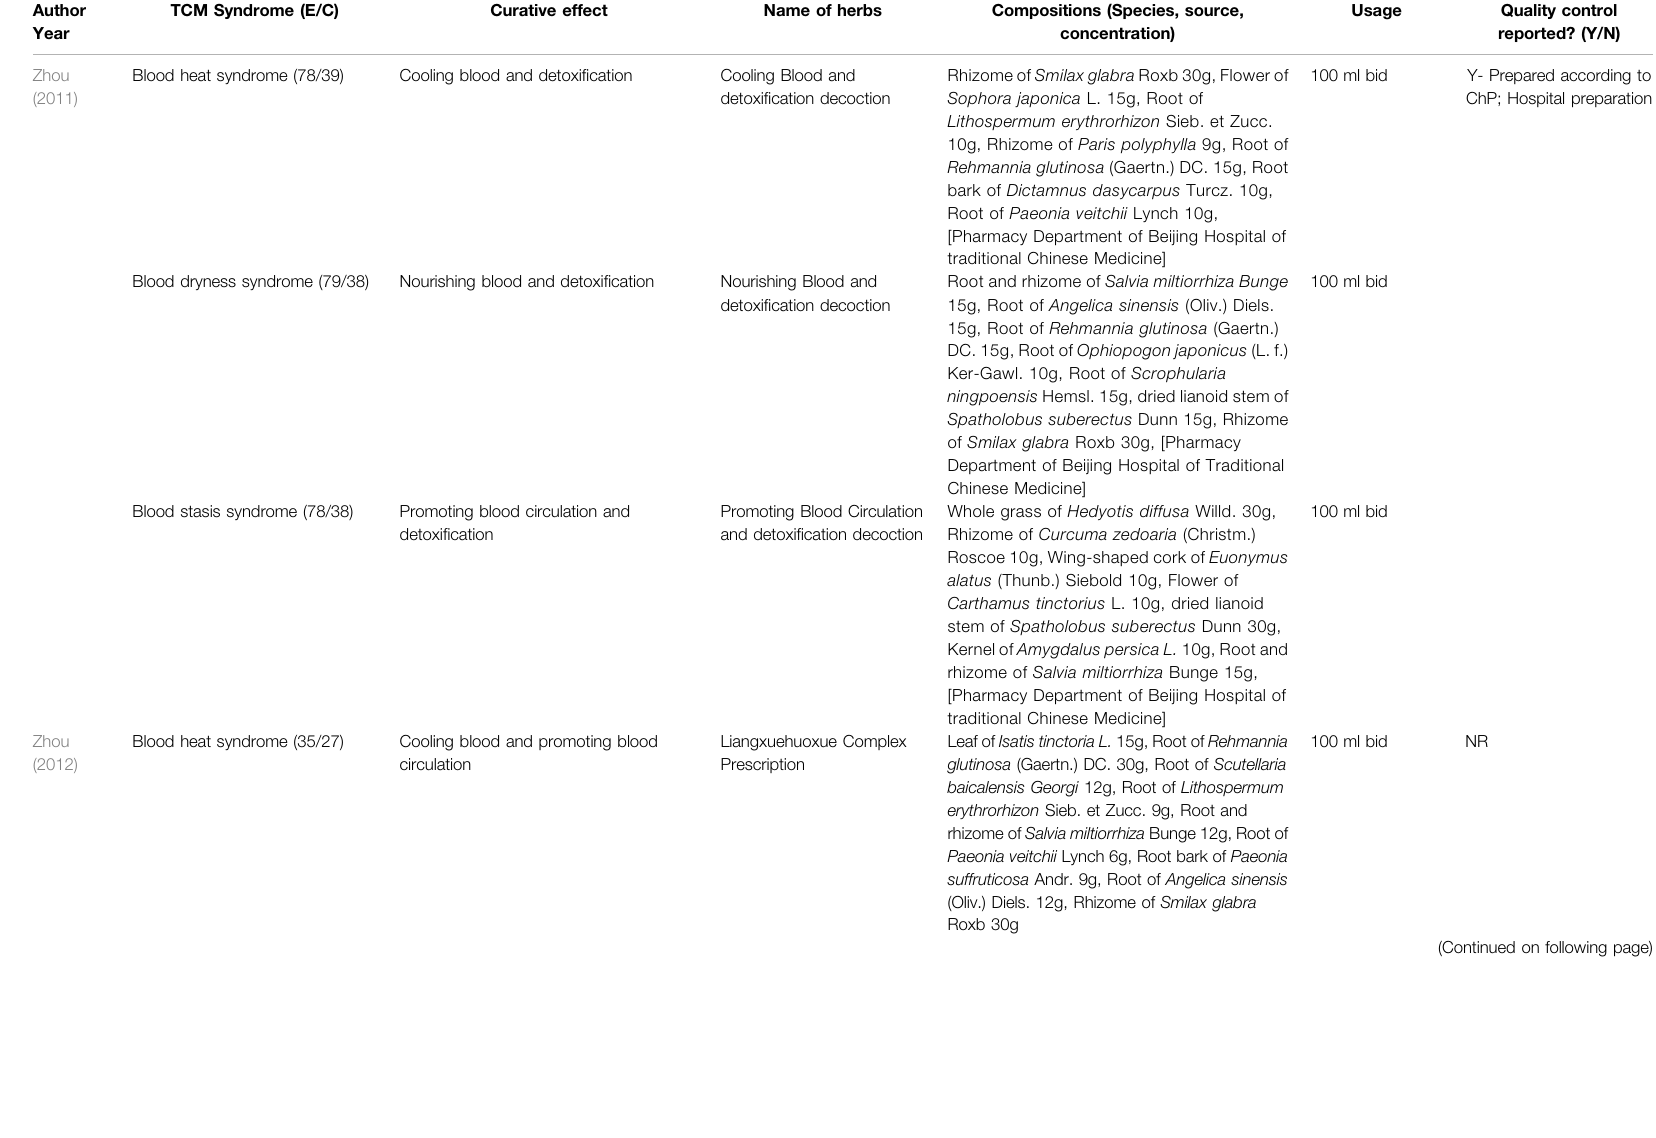
TABLE 1 | ( Continued ) Summary of the characteristics of the included